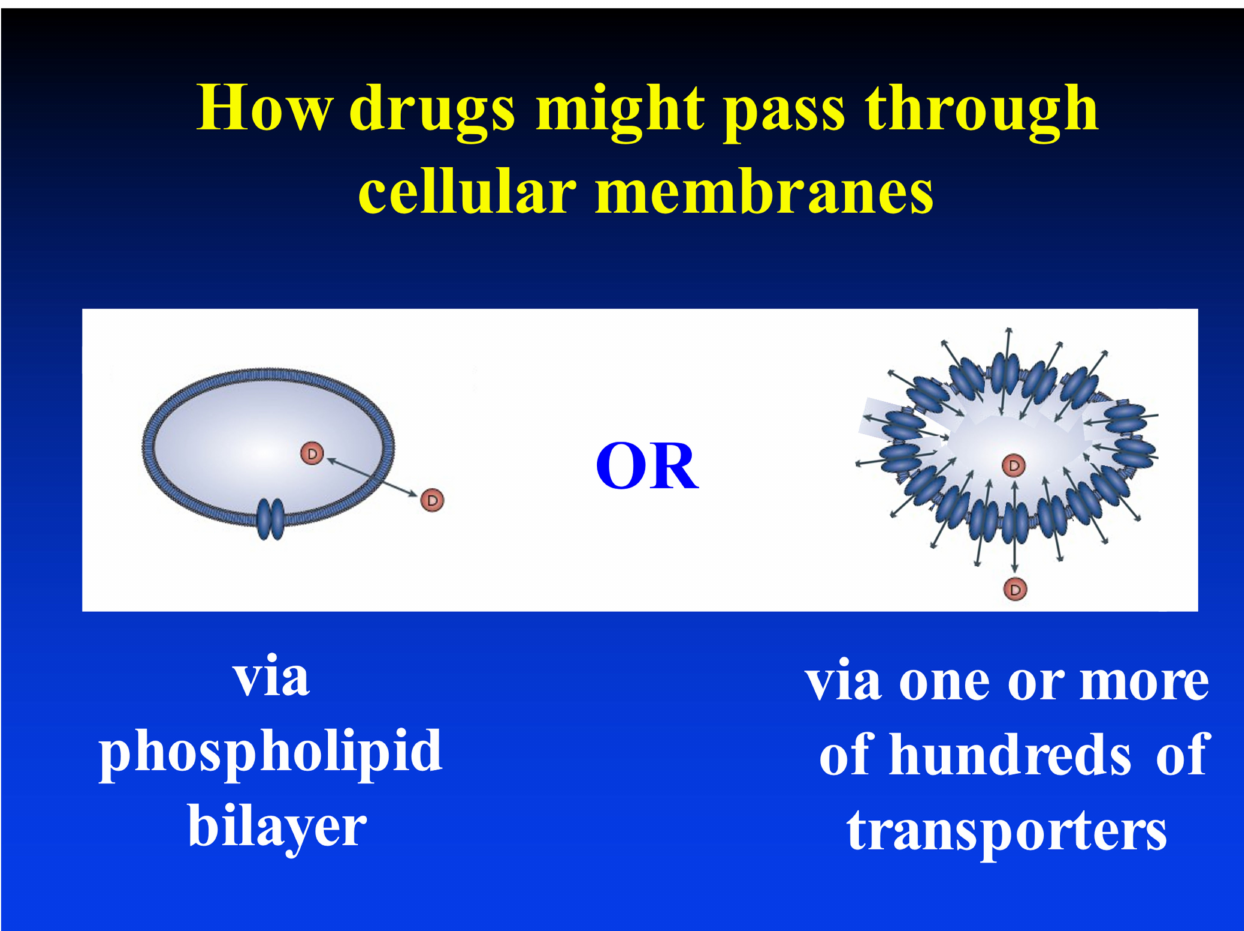
Figure 1. A drug D might pass through a biological membrane in one of two main ways conceptually (we do not here discuss endo- and exocytosis; the focus is only on cases where the drug is considered to cross through the membrane barrier itself). On the left is illustrated transport through phospholipid bilayers, while on the right we illustrate the use of proteinaceous solute carriers to effect entry and exit of the drug. The crux of this review is that the mode on the left does not take place at any meaningful rate in intact biological membranes (since they have a high protein